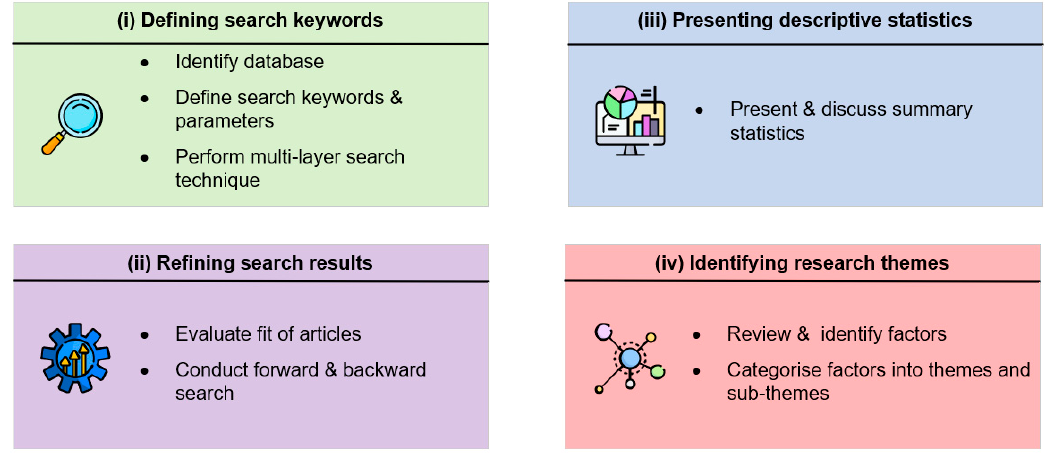
Figure 1. Overview of research method.